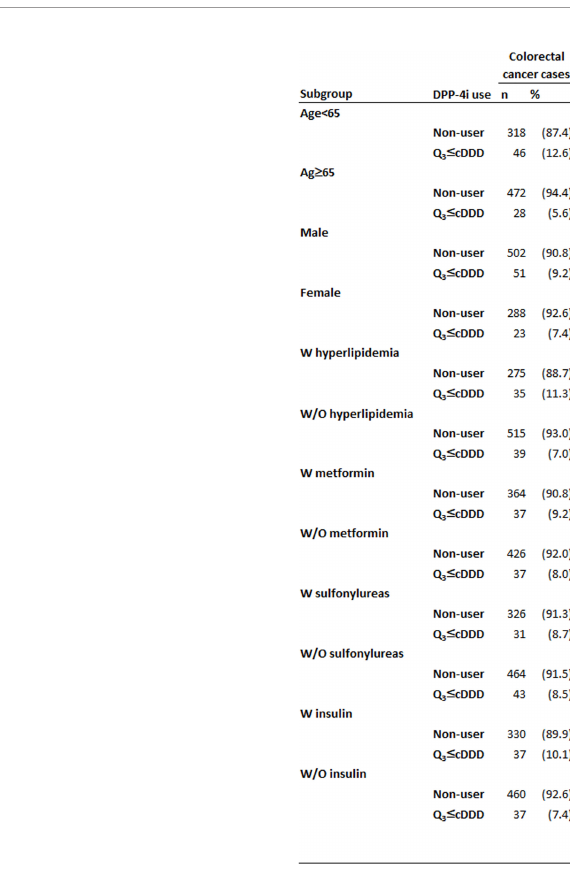
FIGURE 2 | Subgroup analysis of high cDDD group for the association between DPP4is exposure and risk of colorectal cancer among patients with T2DM. *Adjustment for covariates listed in Table 1 , including age, socioeconomic status, modi fi ed CCI, previous and coexisting medical conditions (cholangitis, cholelithiasis, cholecystitis, cirrhosis of liver, alcoholic liver disease, chronic nonalcoholic liver disease, hepatitis B, hepatitis C, in fl ammatory bowel disease, adenomatous polyposis, peptic ulcer, GERD, cardiovascular disease, hyperlipidemia, and hypertension), prescribed medications before the index date of cancer diagnosis (ACEIs/ARBs, beta-2 blockers, diuretics, CCBs, antiplatelet drugs, statin, NSAIDs, and steroids) and other OADs (metformin, thiazolidinedione, sulfonylureas, alpha-glucosidase inhibitor, and insulin). ACEIs angiotensin-converting enzyme inhibitors, ARBs angiotensin receptor blockers, CCBs calcium channel